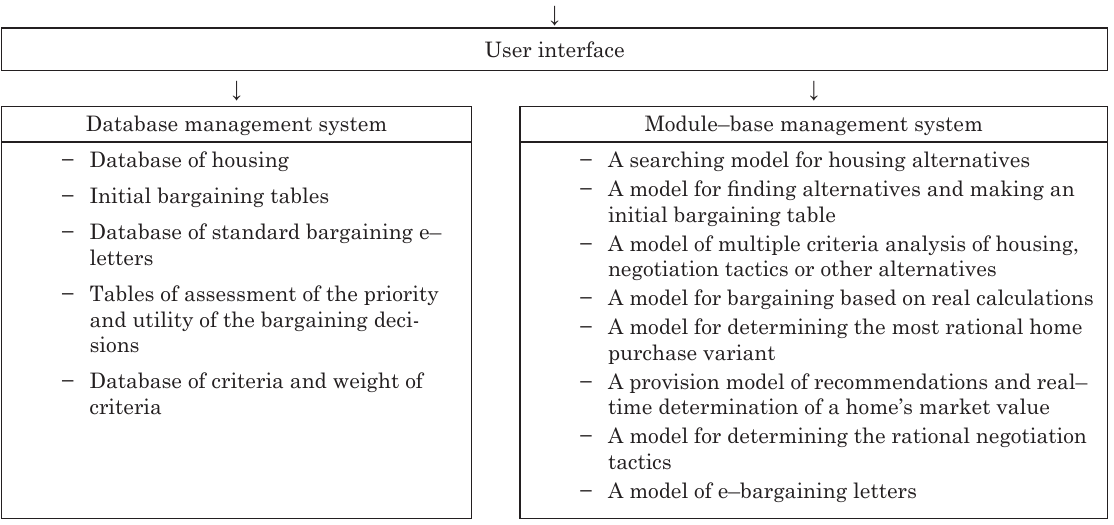
Fig. 1. The components of the Real-Time Housing Multiple-Criteria Bargaining Decision Support Table 1. Criteria for housing bargaining